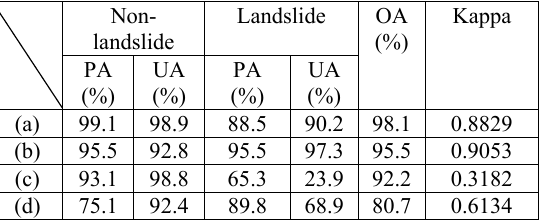
Table 3. Accuracy assessment